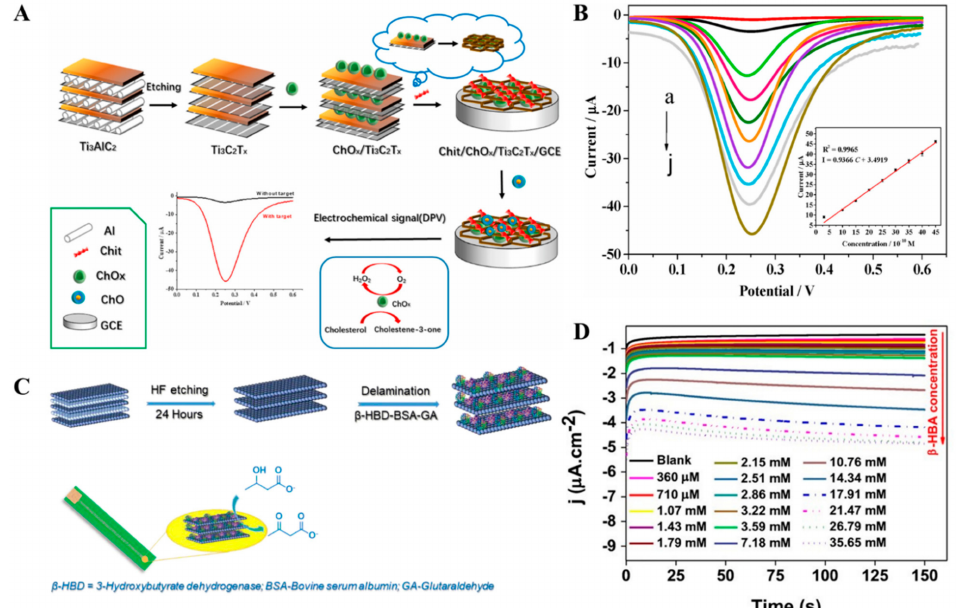
Figure 10. ( A ) Schematic illustration of the fabrication of Chit/ChO x /Ti 3 C 2 T x /GCE for the voltamet- ric determination of cholesterol. ( B ) DPVs at the Chit/ChO x /Ti 3 C 2 T x /GCE in different cholesterol concentrations in the presence of 1 mM Fe(CN) 63 − /4 − containing 0.1 M KCl. Inset is the correspond- ing calibration plot for cholesterol. Reprinted with permission from Ref. [153]. Copyright © 2021 Elsevier. ( C ) Schematic representation of the fabrication of MXene decorated β − hydroxybutyrate de- hydrogenase. ( D ) Amperometric i − t curve at the Au-PCB/Ru/MXene − β − HBD − NAD + − GA − BSA electrode for the determination of β − HBA. Reprinted with permission from Ref. [172]. Copyright